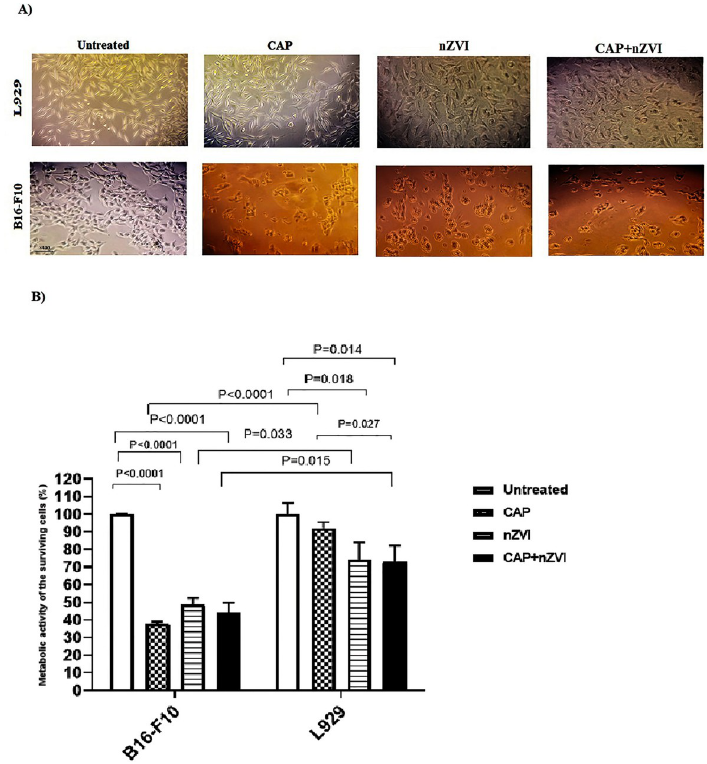
Fig 3. The effect of CAP, nZVI, and combined of CAP and nZVI on morphological features and cell viability of B16-F10 tumor cells and L929 normal cells. A) Morphological alterations visualized under an inverted microscope ( × 100). B) Cell viability was assessed using the MTT